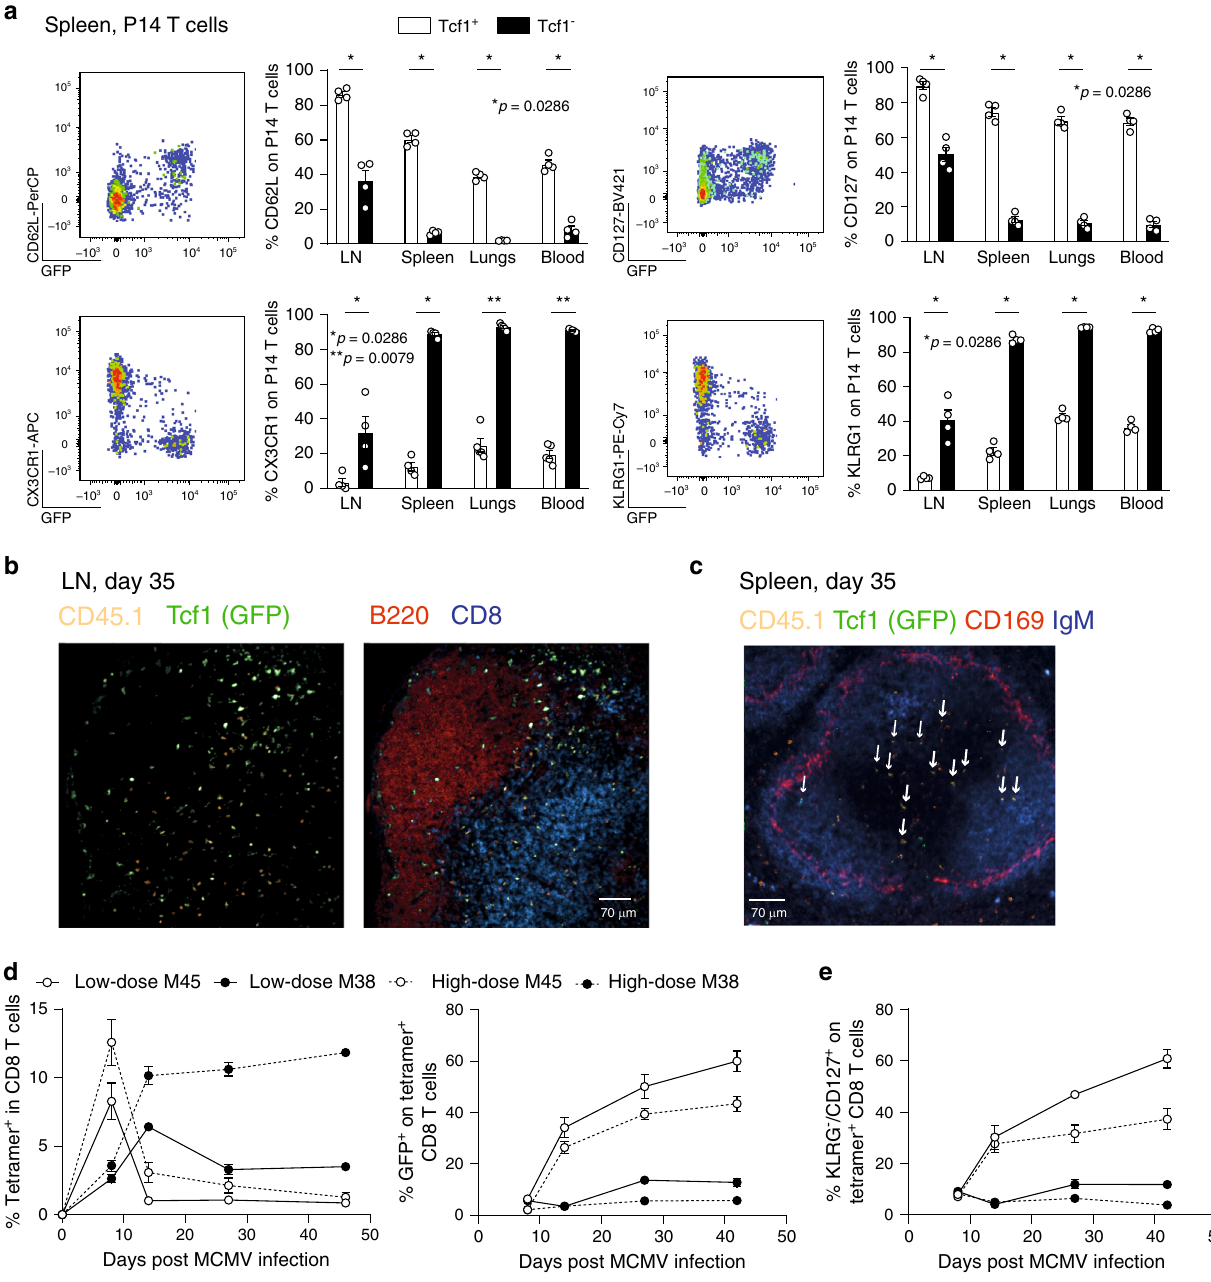
Fig. 2 Tcf1 + cells express markers associated with a central memory phenotype. a CD45.1 + Tcf7 GFP P14 cells were adoptively transferred into WT mice that were subsequently infected with 2 × 10 5 PFU MCMV- ie2 -GP33. Representative fl ow cytometry plots show the expression of GFP (Tcf1) and the indicated cell surface markers on P14 T cells in the spleen in latent MCMV infection. Bar graphs show the percentage of Tcf1 + (GFP + ) and Tcf1 − (GFP − ) P14 cells expressing the indicated cell surface markers. All bar graphs represent mean ± SEM and each dot represents an individual mouse ( n = 4 – 5). b Immuno fl uorescence staining of an inguinal LN section is shown 5 weeks post MCMV- ie2 -GP33 infection with CD45.1 (P14 T cells) (orange), GFP representing Tcf1 (green), B220 (red) and CD8 T cells (blue). Scale bar is 70 µ m. Section is representative of three individual mice. c Immuno fl uorescence staining of a splenic section is shown 5 weeks post MCMV- ie2 -GP33 infection with CD45.1 (P14 T cells) (orange), GFP representing Tcf1 (green), CD169 (red) and IgM (blue). Scale bar is 70 µ m. Arrows indicate Tcf1 + cells determined by GFP expression. Section is representative of three individual mice. d Tcf7 GFP mice were infected with a low (10 3 PFU) or a high (10 6 PFU) dose of MCMV Δ m157. The percentage of M45- and M38-speci fi c CD8 T cells, determined by MHC Class I tetramer binding (left graph) and the percentage of tetramer + CD8 T cells expressing GFP (right graph) is shown in the blood as mean ± SEM ( n = 4). e The percentage of tetramer + CD8 T cells expressing CD127 in the blood is shown as mean ± SEM ( n = 4). a – e One experiment out of 2 or 3 independent experiments is shown ( n = 3 – 5 mice). * p < 0.05, ** p < 0.01; statistical signi fi cance was determined using the two-sided non- parametric Mann – Whitney test. Source data are provided as a Source Data